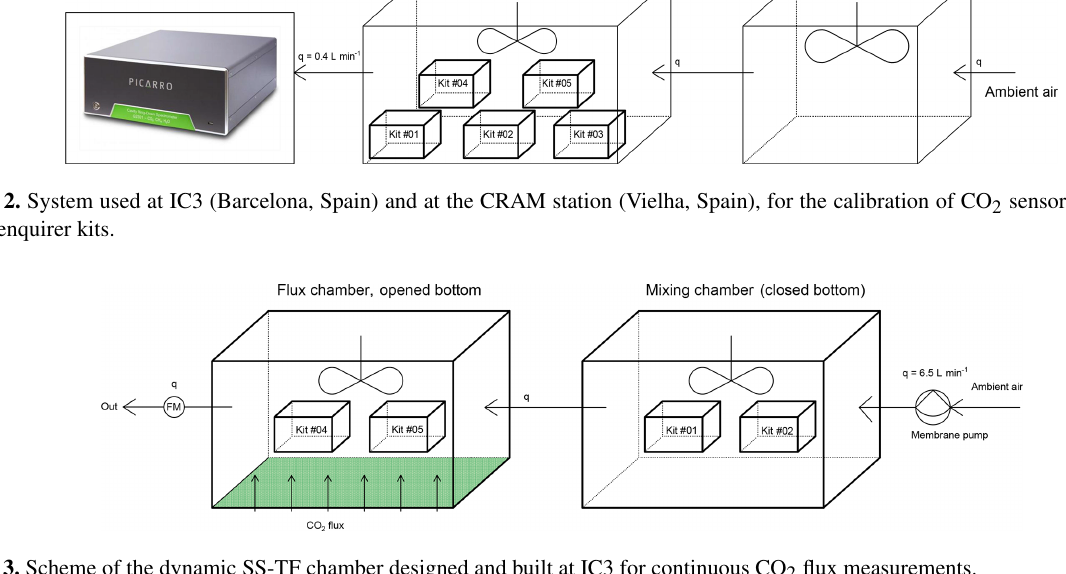
Figure 3. Scheme of the dynamic SS-TF chamber designed and built at IC3 for continuous CO 2 flux measurements.